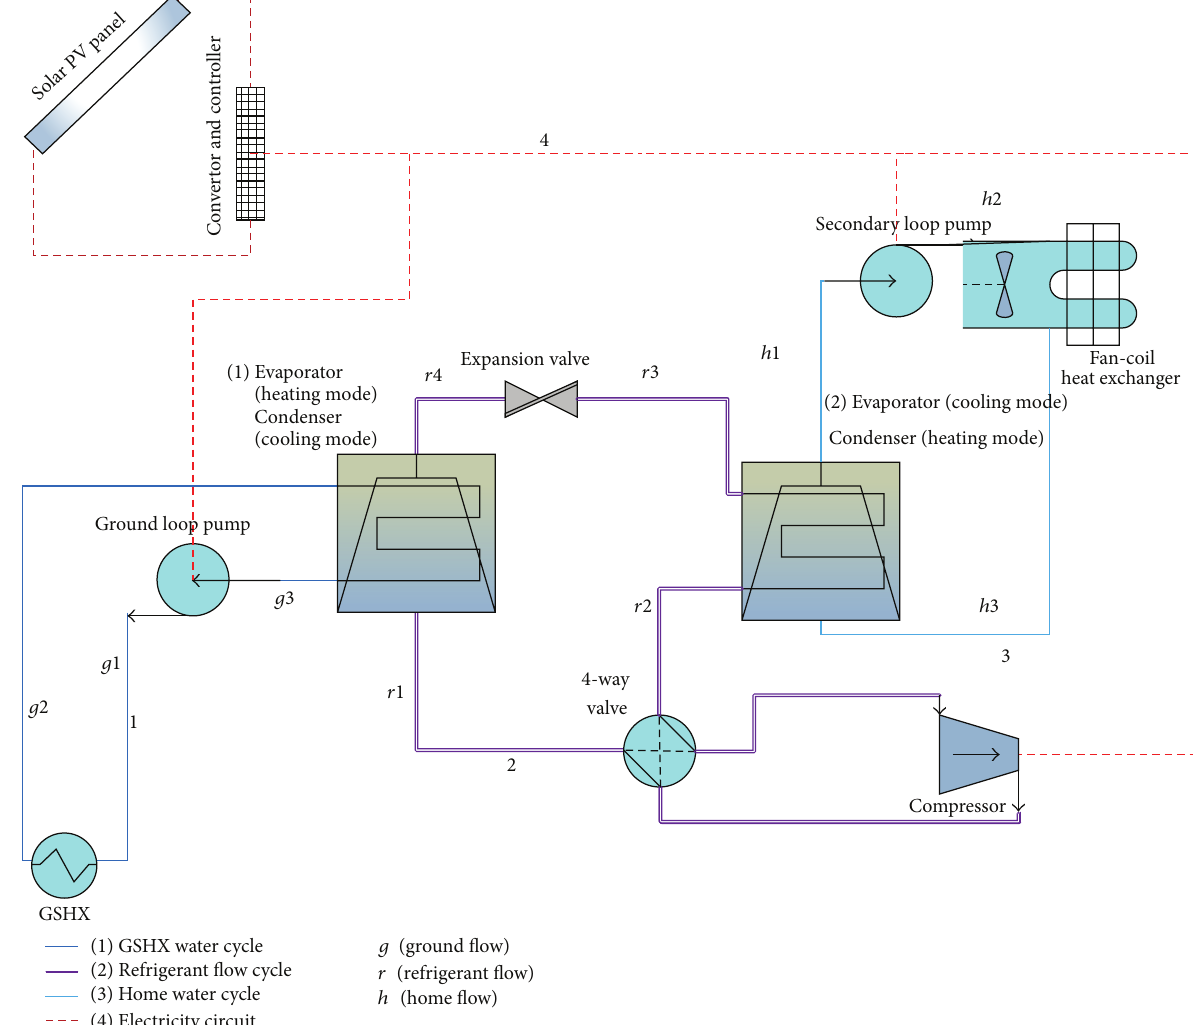
Figure 3: Flow diagram of the integrated solar assisted GSHP